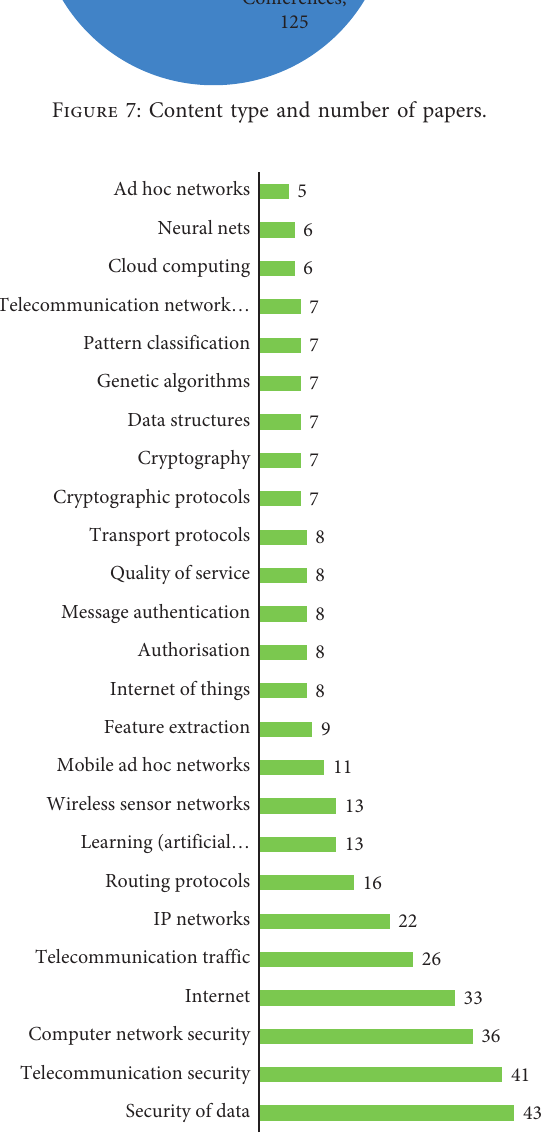
Figure 8: Content type and number of papers.